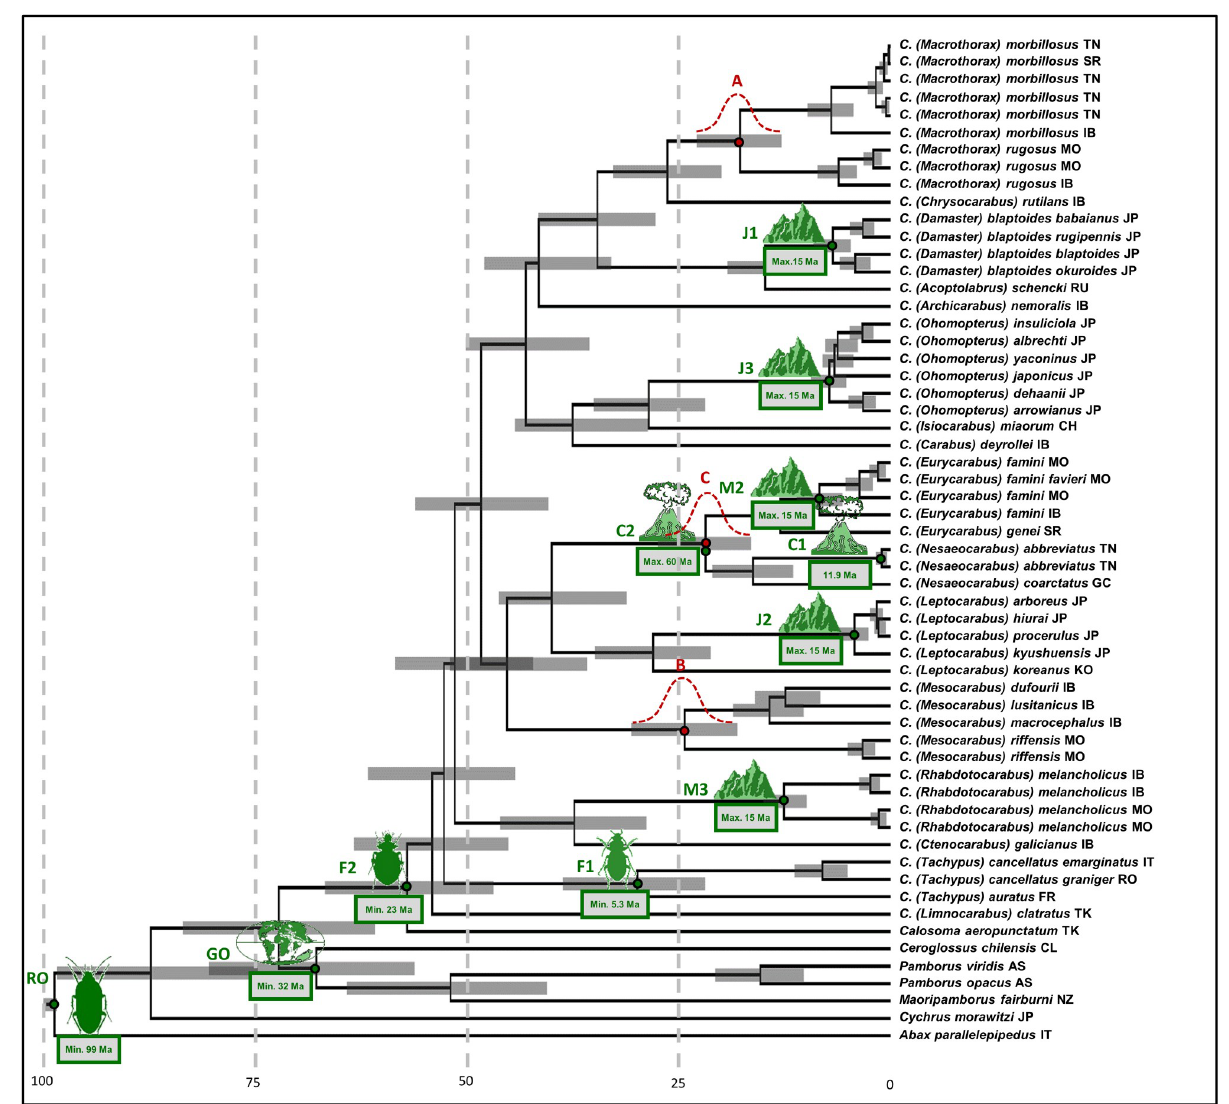
Fig 1. Ultrametric time-calibrated phylogenetic tree obtained with BEAST2 for nd5 data in Carabus . Green symbols depict calibration points employed (see Table 2 for details). Red symbols depict cladogenetic events whose age distributions (see Table 3) were utilized in subsequent analyses.